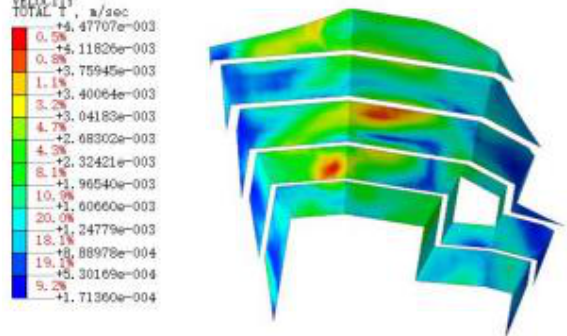
Figure 18. The vibration velocities of retaining walls at 300 ms.